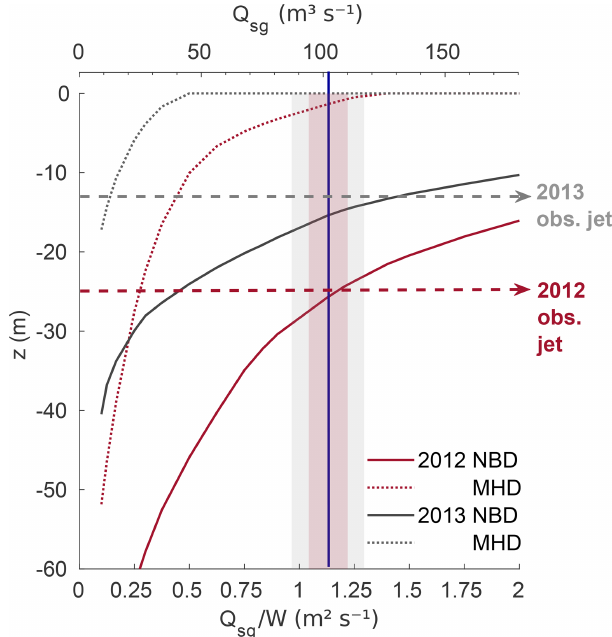
Figure 8. SS runoff for the total catchment ( C tot , darker lines) and the major subcatchment ( C 1 , lighter lines). Daily runoff estimates are shown from June to August of (a) 2012 and (b) 2013. The shaded regions comprise the field survey period (17–27 July, DOY 199-209 in 2012; 24–31 July, DOY 205-212 in 2013). The average runoff over the field survey period for C 1 is shown inside the shad- ing by a dotted line. (c) Cumulative runoff volume throughout both years, 2012 (red) and 2013 (dark grey), expressed in Gt.